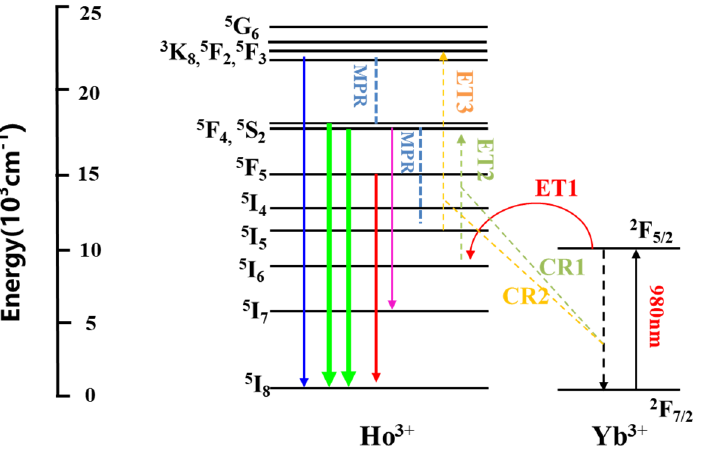
Figure 4. Schematic diagram of energy level transition of Mg 2+ − doped LiYF 4 :Yb 3+ /Ho 3+ UCMPs. The red–green light intensity ratio is an essential standard to evaluate the luminescence performance of luminescent materials. Figure 5a shows the changes in the upconversion red–green light intensity ratio (R/G = I 657nm /I 543nm ) of LiYF 4 :Yb 3+ /Ho 3+ UCMPs doped with different Mg 2+ ion concentrations. With the change in Mg 2+ ion concentration, the conversion of the ratio of red light to green light of UC luminescence is only about 10%, indicating that the UC luminescence of the sample has good monochromaticity, and is affected only slightly by the concentration of Mg 2+ ion doping. In Figure 5b, the visible light colors of LiYF 4 :Yb 3+ /Ho 3+ with different concentrations of Mg 2+ ion doping are exhibited in the CIE color coordinates (without interference by UV/IR light). The coordinates of LiYF 4 :Yb 3+ /Ho 3+ UCMPs with different concentrations Mg 2+ ion doping were (0.2653, 0.5731), (0.2809, 0.5792), (0.2977, 0.5563), (0.2844, 0.6024), (0.2990, 0.6127), and (0.3151, 0.6204),